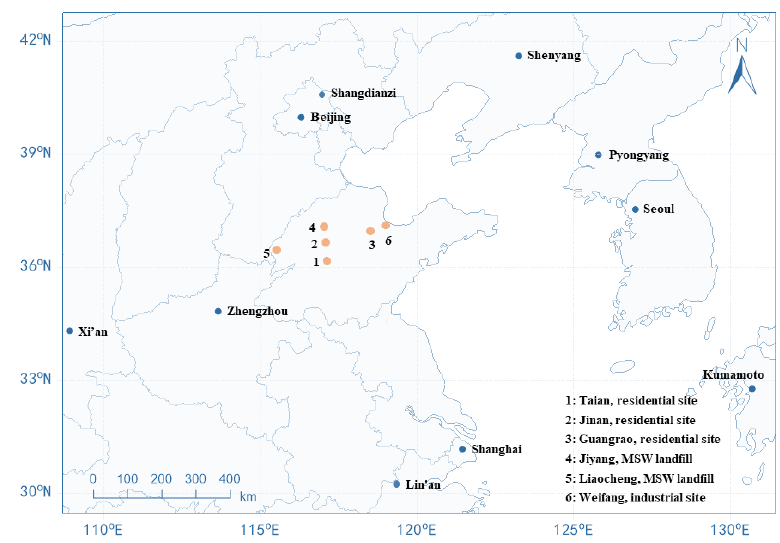
Figure 1. The specific sampling locations in Eastern China.